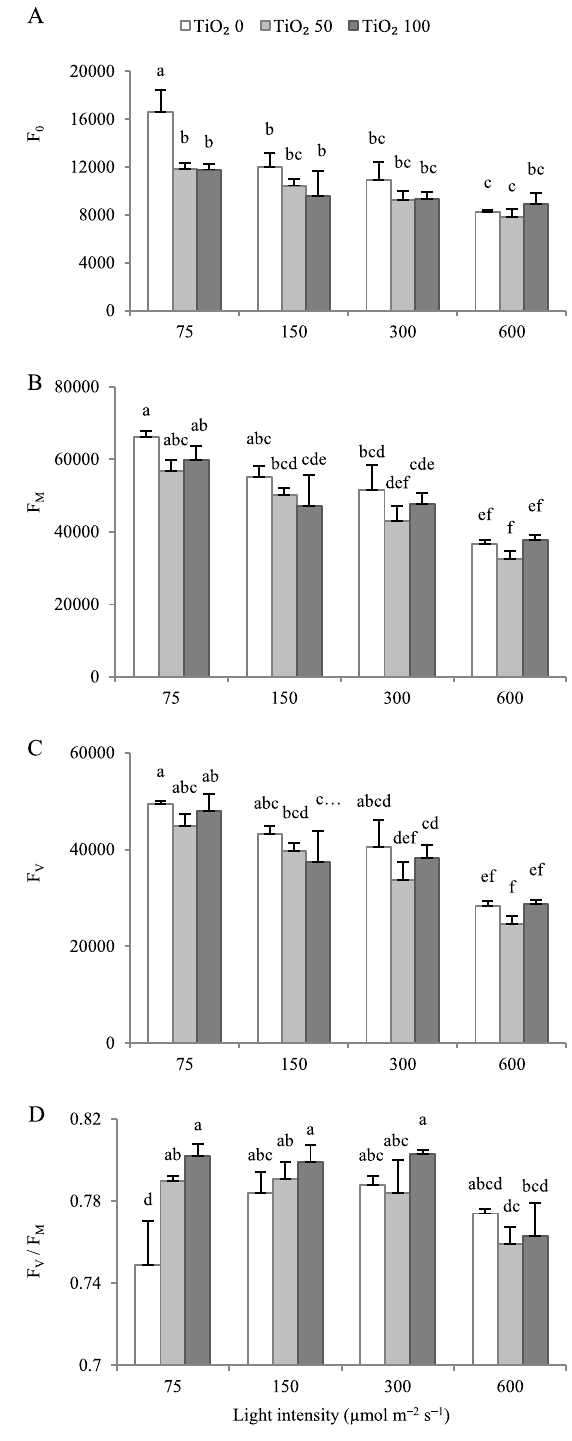
Figure 7. Effect of cultivation light intensity (75, 150, 300 and 600 µmol m −2 s −1 ) and spray treatment (once a week, and three times in total) with titanium dioxide (TiO 2 ) nanoparticles (open, grey, and dark grey for 0, 50 and 100 µmol L −1 , respectively) on minimum fluorescence when all PSII reaction centers are open (F 0 ; A ), maximum fluorescence when all PSII reaction centers are closed (F m ; B ), variable fluorescence of the dark-adapted sample (F v ; C ) and maximal quantum yield of PSII photochemistry (F v /F m ; D ) (equations and explanations in Table 3) of radish cv. Cherry belle plants. Nine replicate plants were assessed per treatment. Bars represent SEM. In traits, where the interaction of the two factors (light intensity, TiO 2 nanoparticle level) was significant, different letters indicate significant